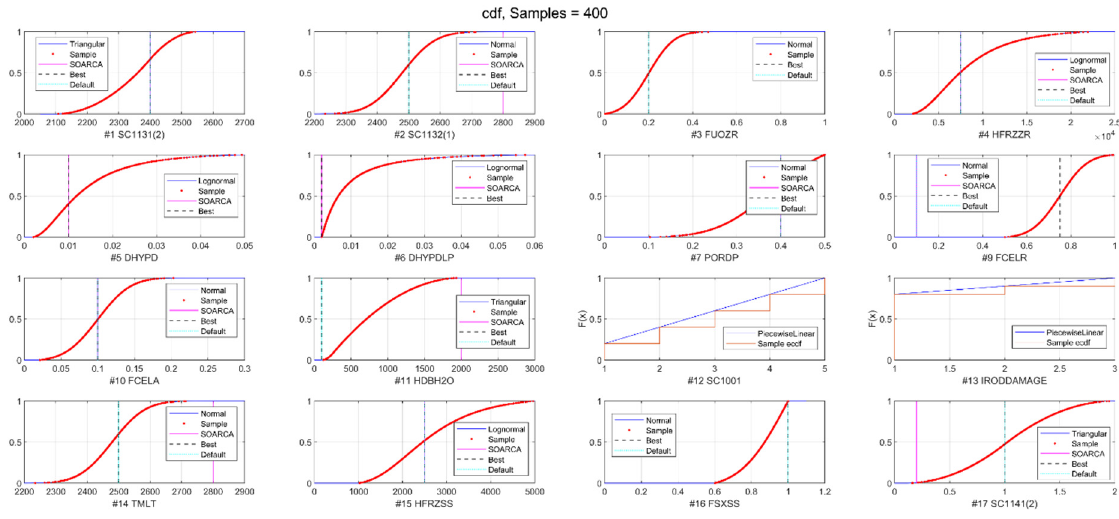
Figure A2. CDF functions and samples for FPT-1 model.